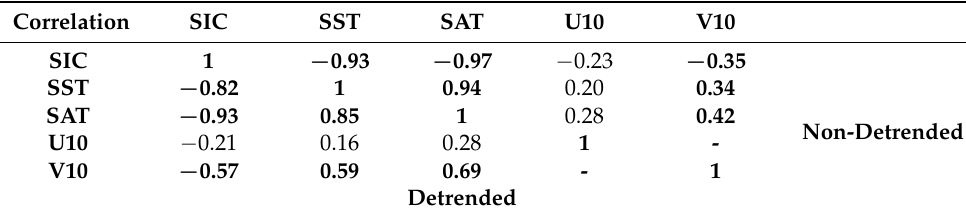
Table 2. Cross-correlation matrix between annual mean SST, SIC, and atmospheric parameters, including surface air temperature (SAT), zonal, and meridional wind components (U10, V10). The lower left triangle represents the correlations between the detrended time series, while the upper right triangle shows the correlations, including the trends. Significant correlations ( p -values < 0.05) are highlighted in